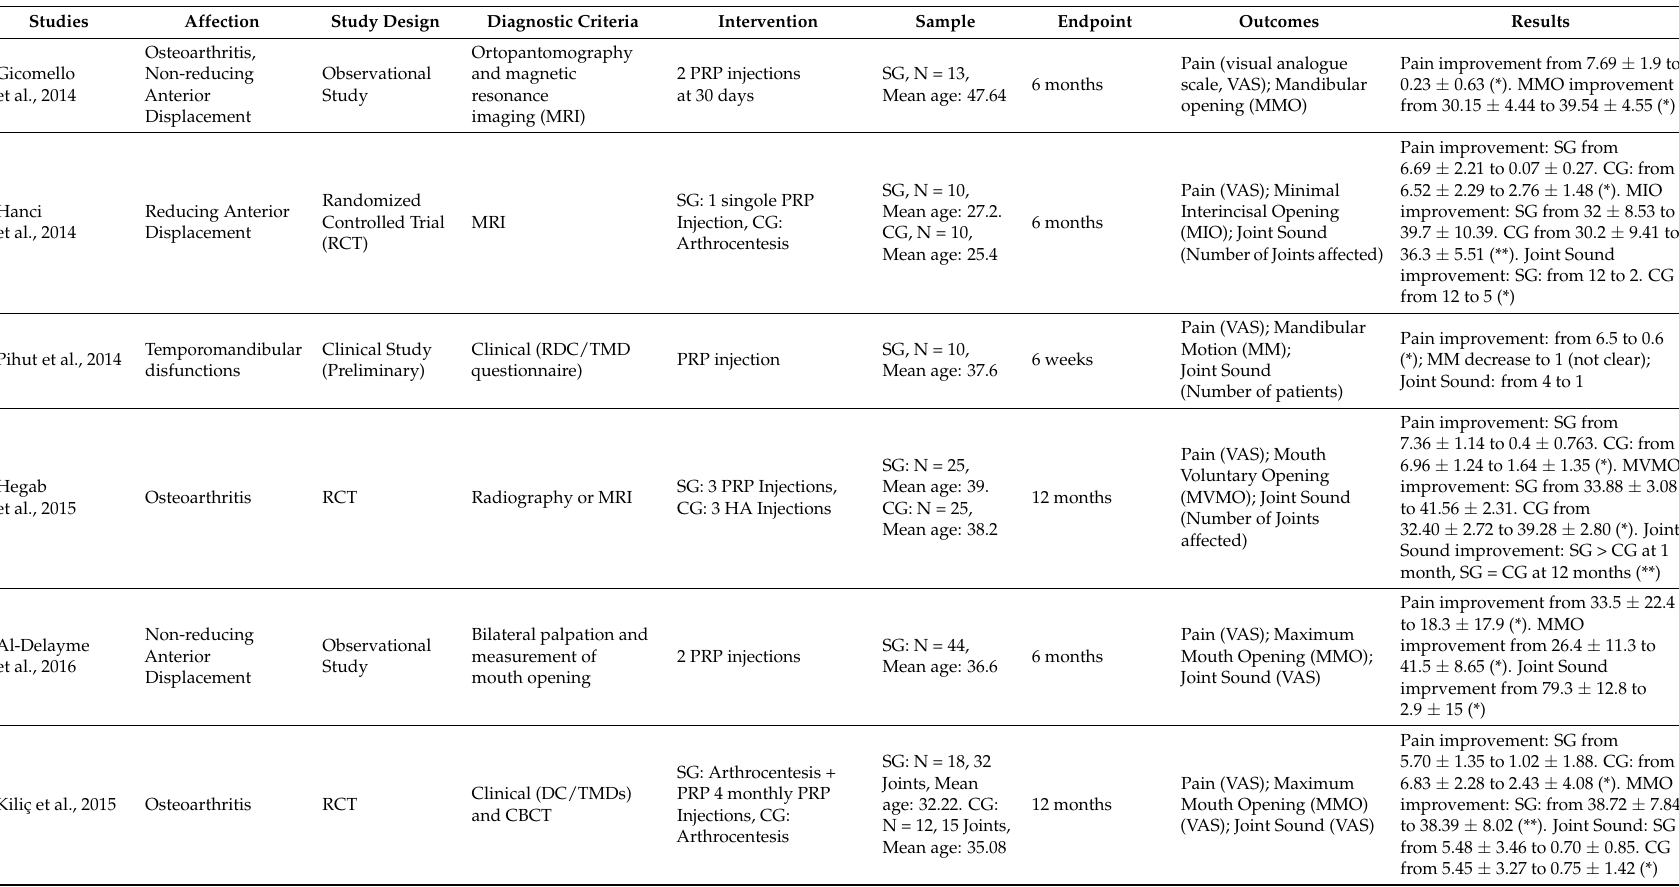
Table 4. Results. SG: Sample Group; CG: Control Group; RDC/TMD: Research Diagnostic Criteria for Temporomandibular Disorders; DC/TMD: Research Diagnostic Criteria for Temporomandibular Disorders; CBCT: Cone Beam Computed